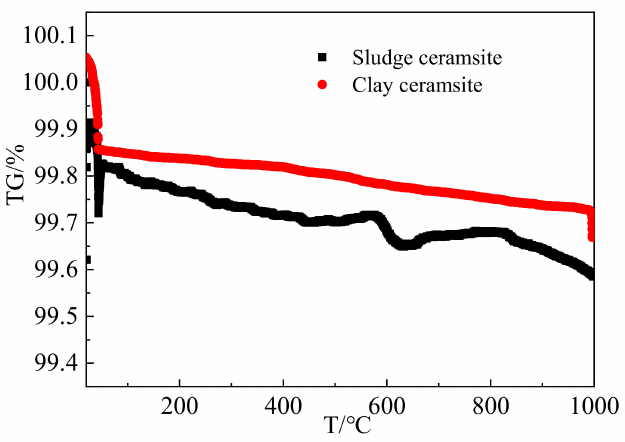
Figure 10. Thermogravimetric analysis curves of specimens.